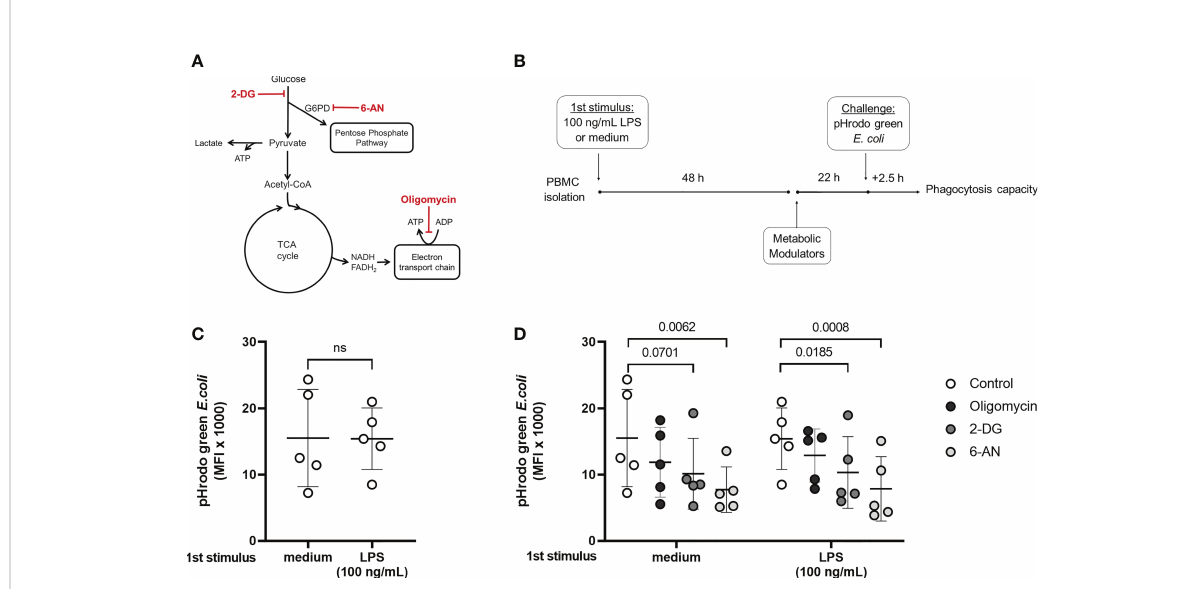
FIGURE 4 Phagocytic capacity in control and endotoxin tolerant PBMCs is affected by the modulation of cell metabolism. (A) : Schematic fi gure of the inhibition of cell metabolism using 2-DG, 6-AN, and Oligomycin and its speci fi c targets. (B) : PBMCs were incubated for 48h (1 st stimulus) with medium or 100 ng/mL of LPS, washed, and incubated for 22 h with the metabolic modulators before exposition to pHrodo green E. coli particles for 2.5 h. (C) : Phagocytic capacity of control (medium) and endotoxin tolerant (100 ng/mL LPS) CD14 + monocytes measured as the median fl uorescence intensity (MFI) of pHrodo green by fl ow cytometry. (D) : Phagocytic capacity of control and endotoxin tolerant monocytes incubated with metabolic inhibitors. Graphs show mean and SD and each dot represents one individual donor evaluated in all experimental conditions (n = 5 donors); p-values indicate differences between each condition as measured by paired Student ’ s t-test (C) or repeated measures one-way ANOVA followed by Bonferroni posttest (D) . ns, not signi fi